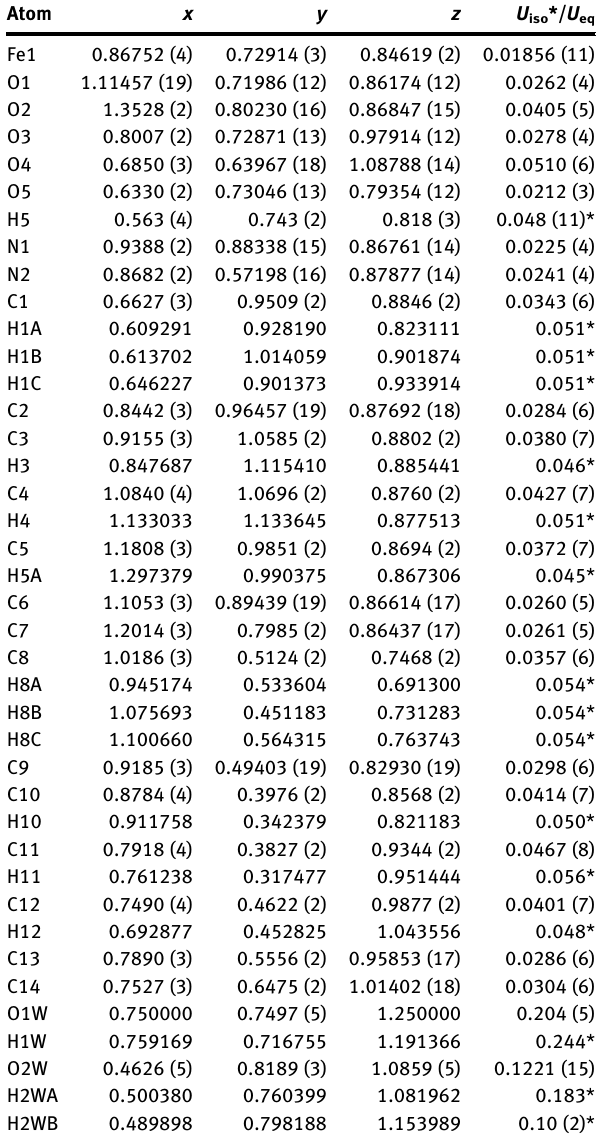
isotropic displacement parameters (Å 